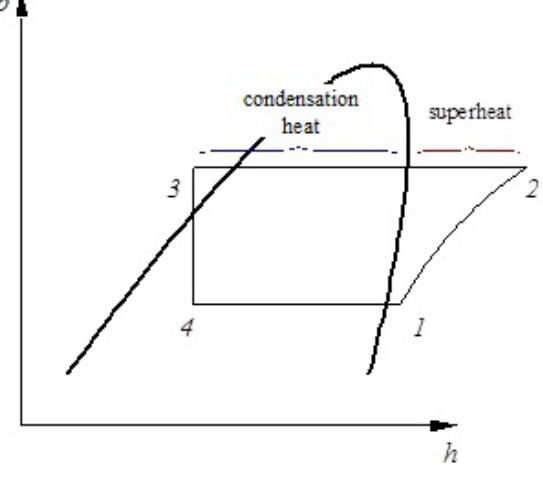
Figure 15: Superheat in the refrigeration